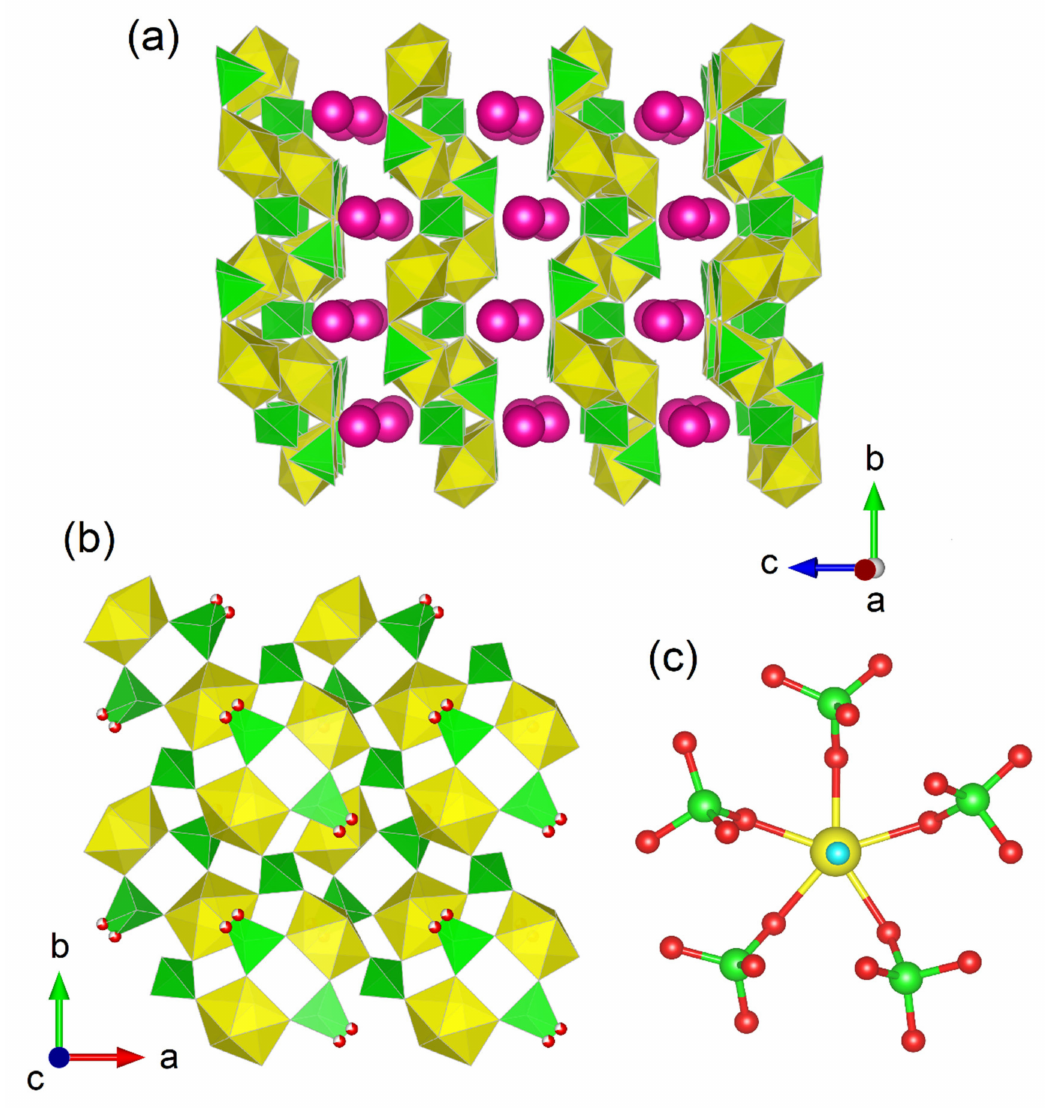
Figure 1. Structural representation of orthorhombic Rb 2 [(UO 2 ) 2 (SeO 4 ) 3 ] in space group P 4 2 / ncm in ( a ) general representa- tion, ( b ) in the [001] direction illustrating the layer configuration of the structure and also disordered O(6) oxygens, and ( c ) highlighting the coordination motif of UO 2 (SeO 4 ) 8 − units. Note yellow polyhedra, green polyhedra, green spheres, yellow spheres, red spheres and blue spheres respectively represent UO 7 , SeO 4 , Se, U, O and uranyl O units/atoms